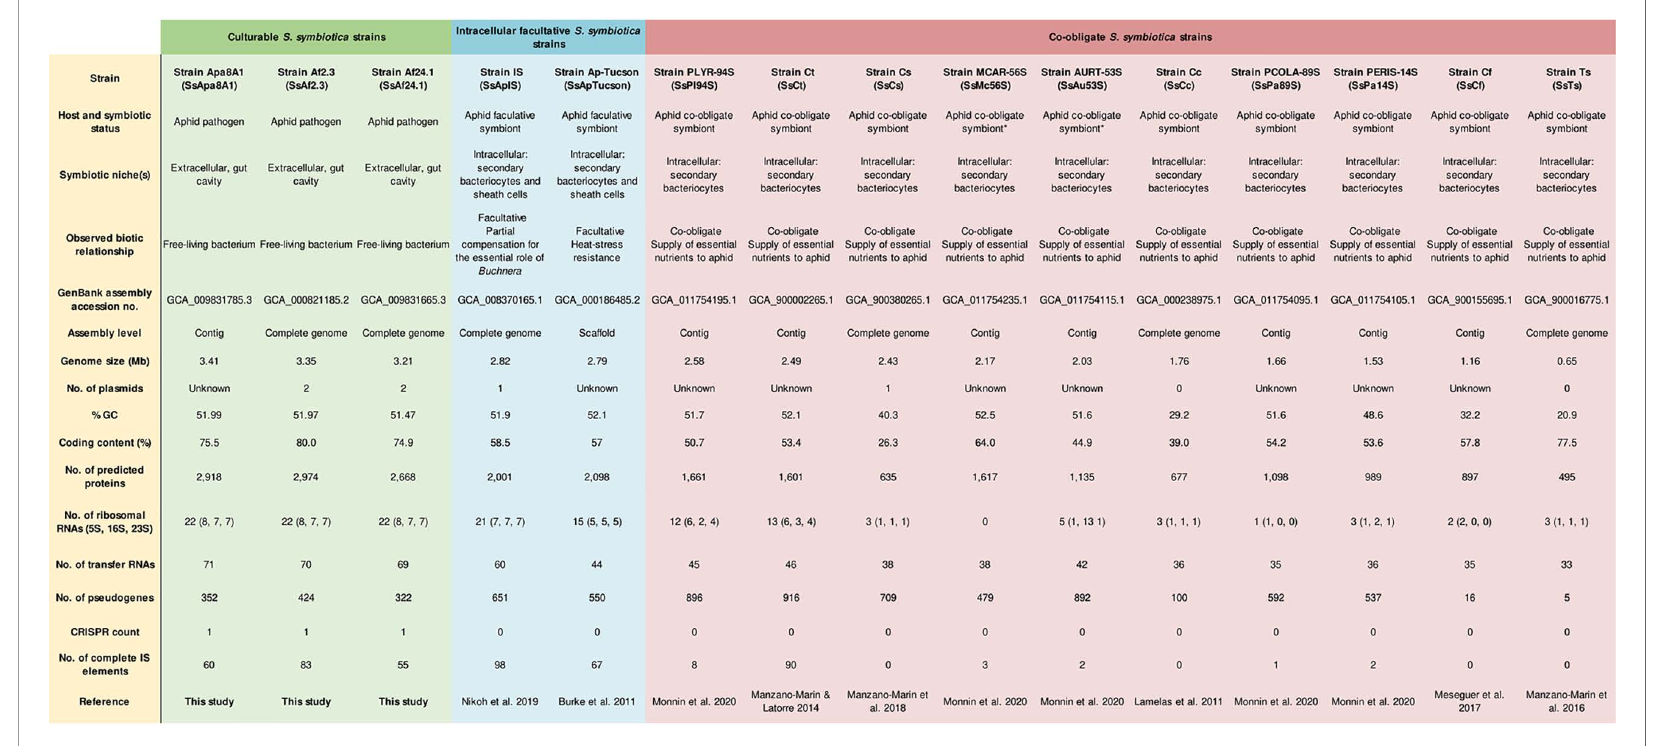
FIGURE 1 | General genomic features of S. symbiotica strains ordered by genome size. *The nature of the relationship between aphids and strains SsMc56S and SsAu53S is currently under